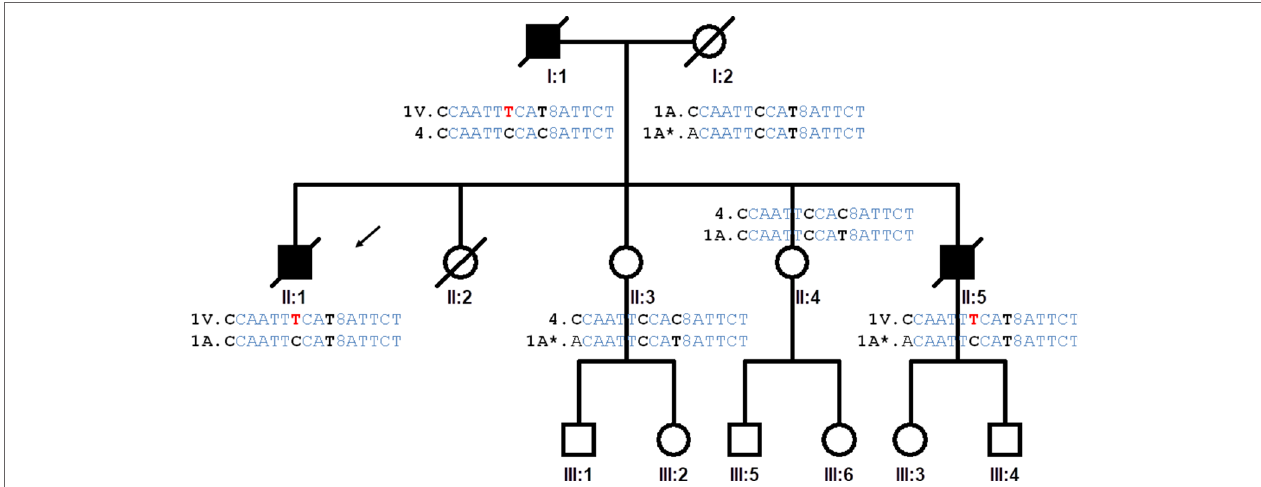
FIGURe 1 | Pedigree of the family studied. The proband is indicated by an arrow (II:1). The haplotypes of the progenitors are inferred from the haplotypes of the offspring. Highlighted in red the genetic variation causing A5V mutation, in bold the single nucleotide polymorphisms that determine the differences between haplotypes of the IBS population. Haplotype (variation order): rs4817415, rs2070422, rs1008270, rs9974610, rs2173962, rs202445, rs121912442, rs4816405, Rs2070424, rs1041740, CA_repeat, rs2833475, rs16988427, rs2833481, rs2070423,